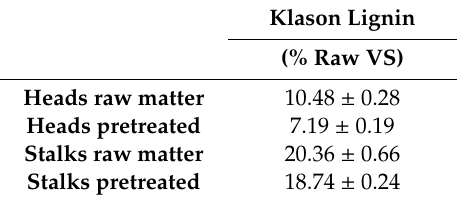
Table 2. Lignin content of raw and pretreated sunflower